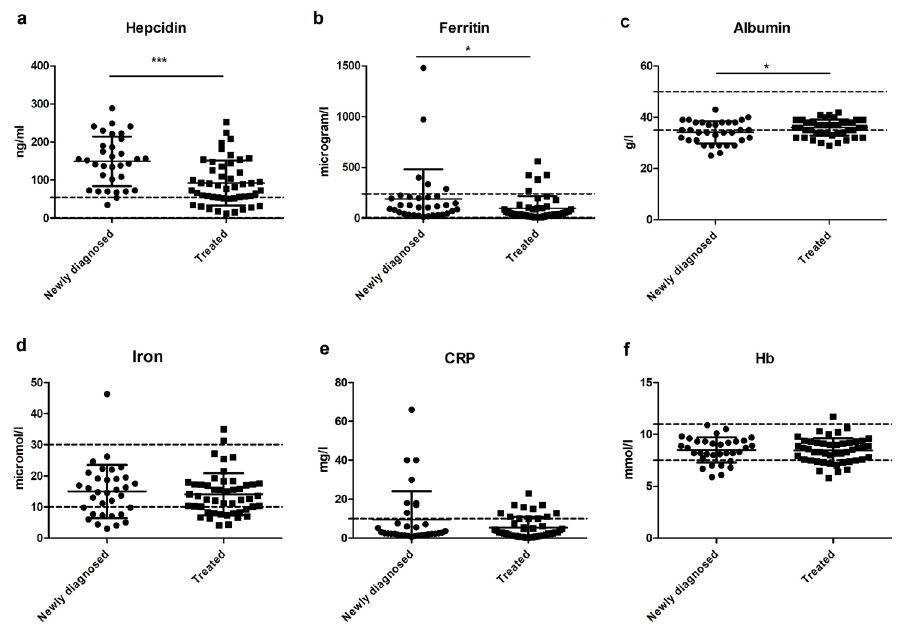
Figure 3. Iron, hepcidin, and inflammation levels in newly diagnosed and treated patients (* p < 0.05, *** p < 0.001). ( a ) Hepcidin levels were higher in newly diagnosed than treated patients with PAH or CTEPH ( p < 0.001). ( b ) Ferritin levels were higher in newly diagnosed than treated patients with PAH or CTEPH ( p < 0.05). ( c ) Albumin levels were lower in newly diagnosed than treated patients with PAH or CTEPH ( p < 0.05). ( d ) Iron levels in newly diagnosed and treated patients with PAH or CTEPH were not different. ( e ) CRP levels in newly diagnosed and treated patients with PAH or CTEPH were not different. ( f ) Hb levels in newly diagnosed and treated patients with PAH or CTEPH were not different.